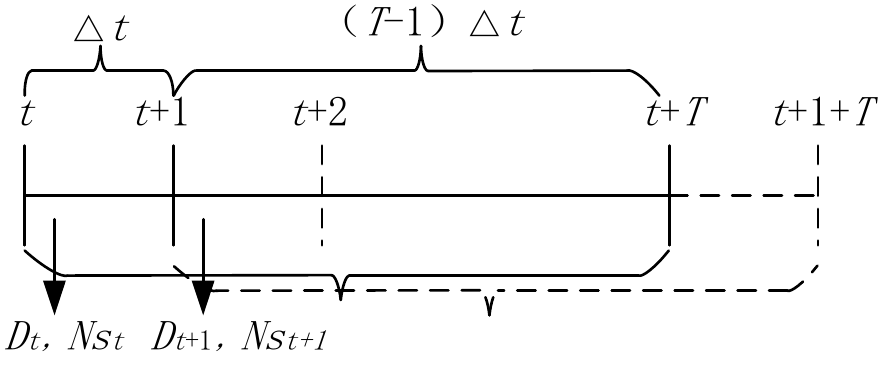
Figure 3. Schematic diagram of rolling forecast.